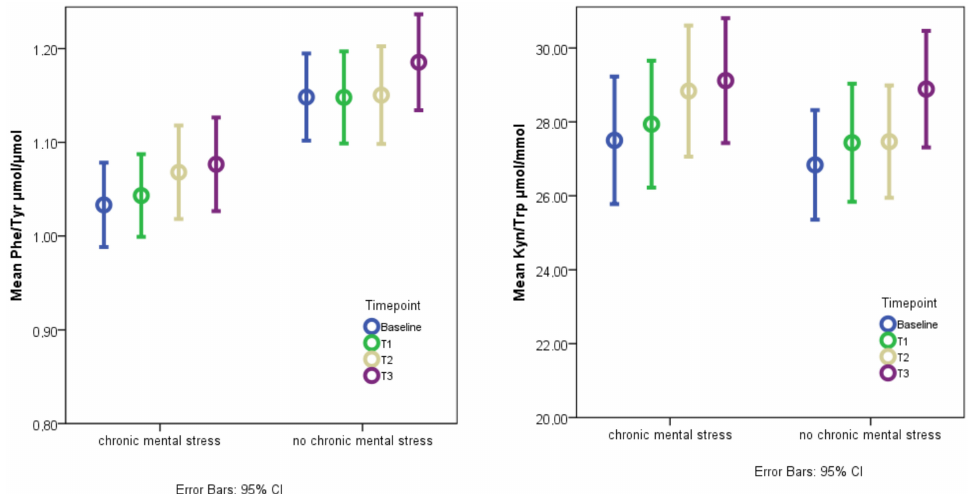
Figure 2. Plots of observed values of neurotransmitter precursor amino acid levels. Plots represent means and 95% confidence intervals (CI) of the observed values. n = 53. Adjusted p -values from the linear mixed model can be found in Tables 2 and 3. Baseline = T0 after 30 min of rest, T1 = immediately after acute mental stress test, T2 = 30 min after acute mental stress test, T3 = 60 min after acute mental stress